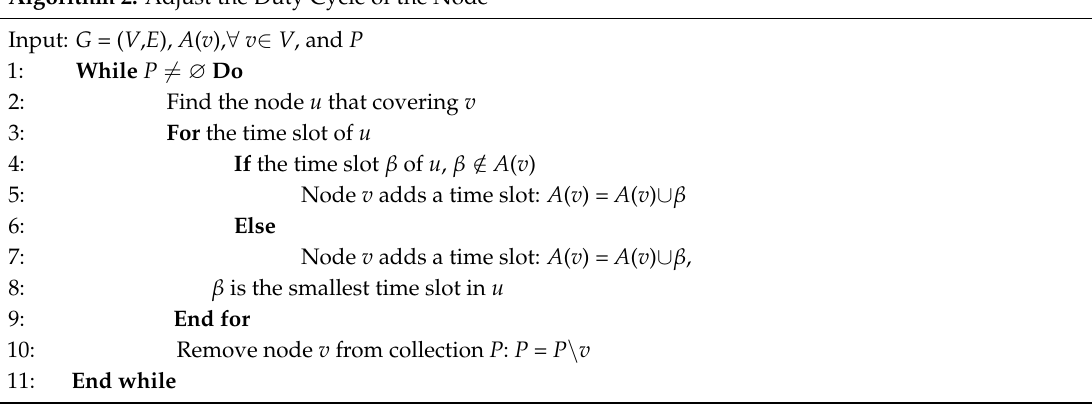
Algorithm 2. Adjust the Duty Cycle of the